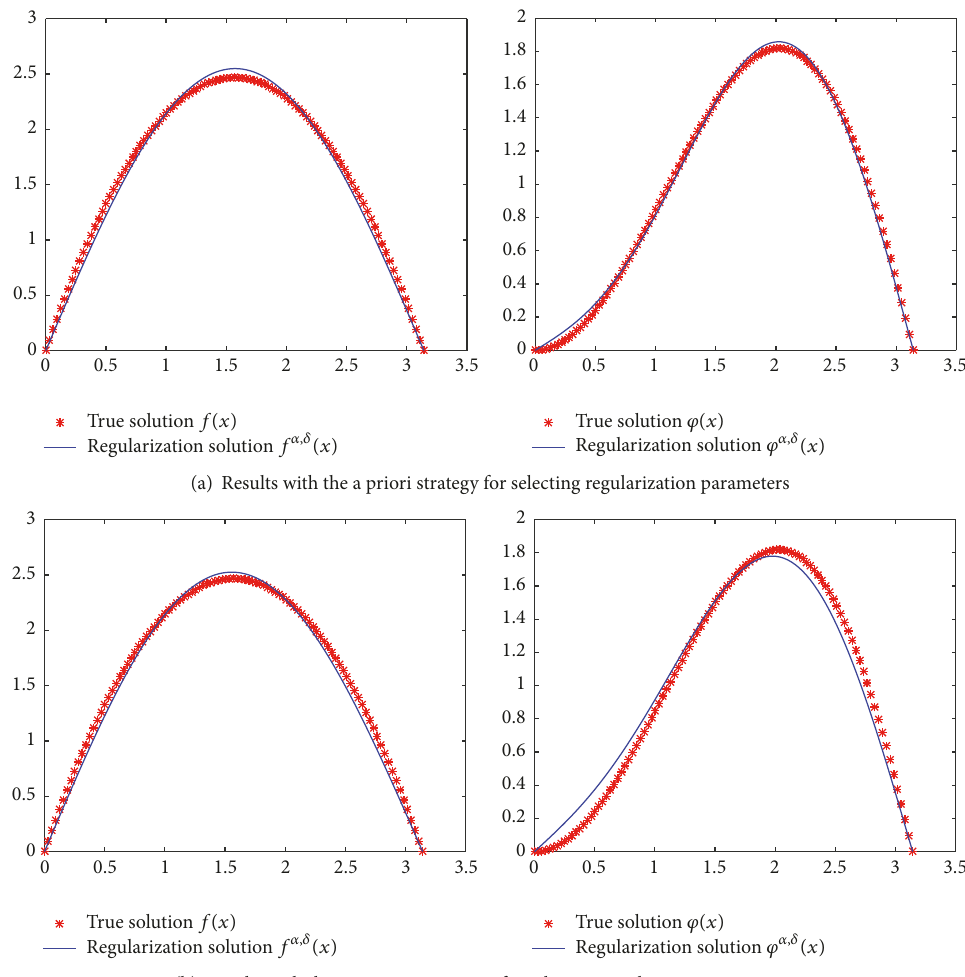
Figure 4: Behaviors of the true and the regularization solution when 𝜌 = 0.10